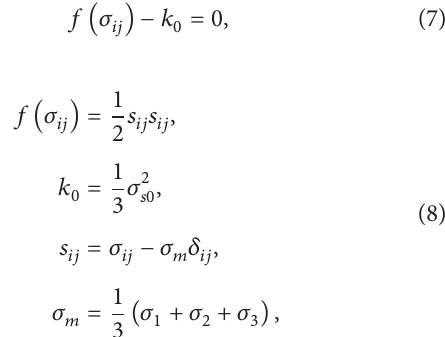
the rolls rotating about the axes 𝑥 , 𝑦 , and 𝑧 , respectively, and 𝐹 𝑦 is the concentrated force in direction